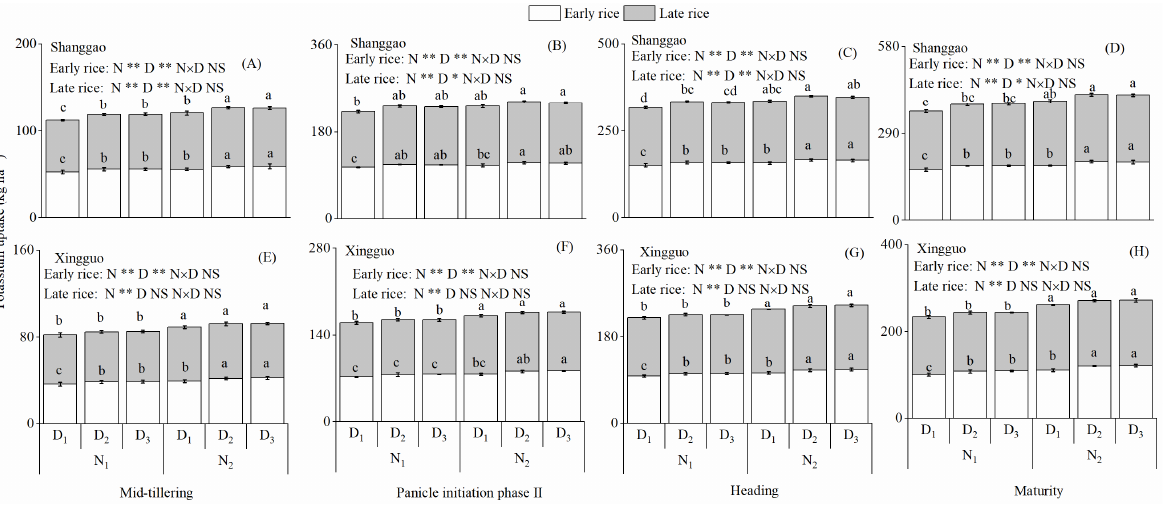
Figure 8. Potassium absorption dynamics of double cropping rice ( A – H ) response to the N rate and plant density in two different ecological regions in 2018. N 1 and N 2 represent 120 and 150 kg ha -1 for early rice and N 1 and N 2 represent 120 and 165 kg ha -1 for late rice. D 1 , D 2 and D 3 represent 86, 143 and 200 plants per m 2 for early rice and D 1 , D 2 and D 3 represent 57, 114 and 172 plants per m 2 for late rice. Values followed by different lowercase letters are significantly different at the 0.05 level. NS, * and ** represent no significant difference and significant difference at the 5% and 1% levels.